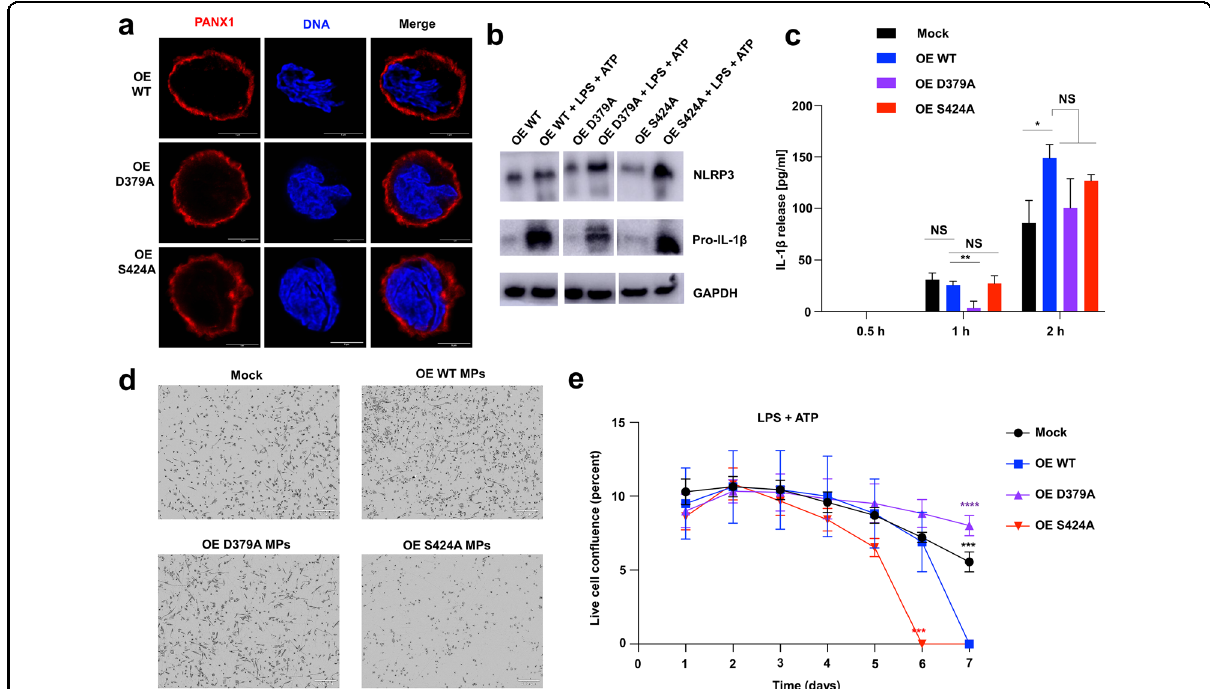
Fig. 5 Cellular localization and pyroptosis-related functional analysis of D379A and S424A in macrophages. a Representative images of the localization of WT and mutant hPANX1 (D379A and S424A) in MPs. The images were collected using the super-resolution STED mode. Scale bar = 5 µm. b Western blot analysis of the NLRP3, Pro-IL-1 β in WT and mutant (D379A and S424A) hPANX1 overexpressing MPs. MPs were treated with LPS (1 µg/ml) and ATP (3 mM) for 24 h. GAPDH was used as a loading control. c IL-1 β release from mock, WT overexpressing and mutant (D379A and S424A) overexpressing MPs. MPs were primed with LPS (1 µg/ml) overnight and stimulated with nigericin (10 µM) for 0.5, 1, or 2 h. IL-1 β release was measured by ELISA. Error bars represent s.e.m. for n = 3. * P < 0.05, ** P < 0.01, NS not signi fi cant (one-way ANOVA followed by Dunnett ’ s test, OE WT set as comparison control). d Phase-contrast images of MPs stimulated by LPS and ATP. Images were acquired with an IncusyteS3 system on day 6. e Time course of live cell con fl uence of MPs. Image data were collected every 2 h and analyzed with an IncusyteS3 system. Error bars represent s.d. for n = 4. *** P < 0.001, **** P < 0.0001 (one-way ANOVA followed by Dunnett ’ s test, OE WT set as comparison